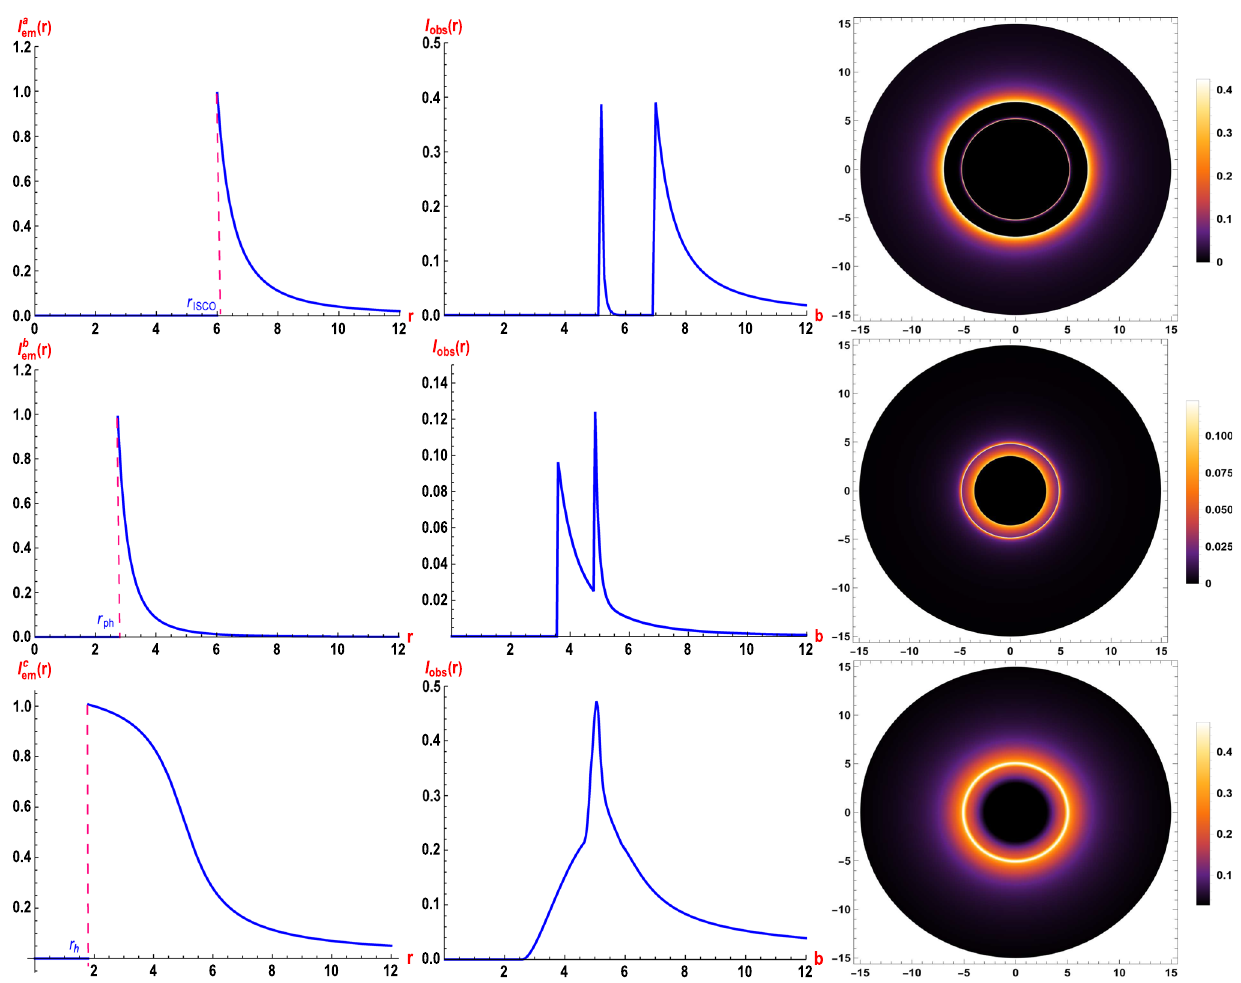
Fig. 6 The optical appearance of thin disk accretion with different emission flow profiles near the NC Charged Kiselev BH. The profiles are depicted for φ = 0 . 01 ,λ = 0 . 1 , Q = 0 . 1, and M = 1. The details can be found in the main